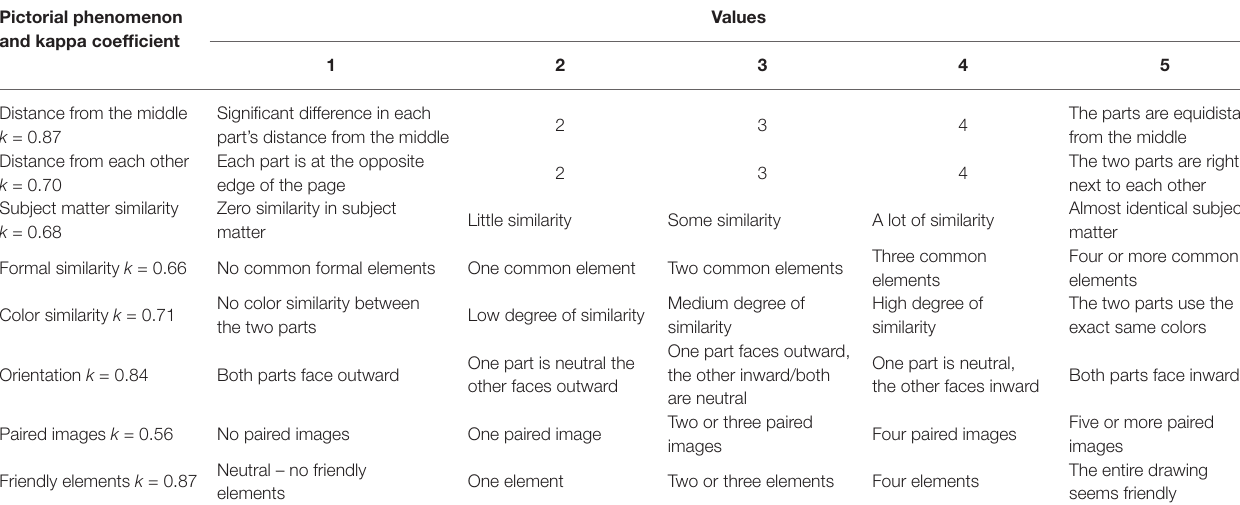
TABLE 3 | Phenomena included in the closeness measure for joint drawings that consisted of two separate drawings on the same page.